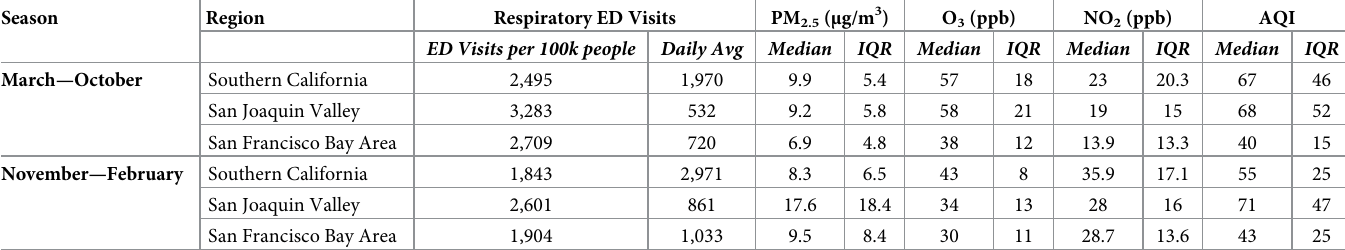
Table 2. Median and inter-quartile range for pollutant concentrations (24-hour PM 2.5 , 8-hour O 3 , and 1-hour NO 2 ) and daily Air Quality Index, by region and sea- son from 2012–2014. Season Region